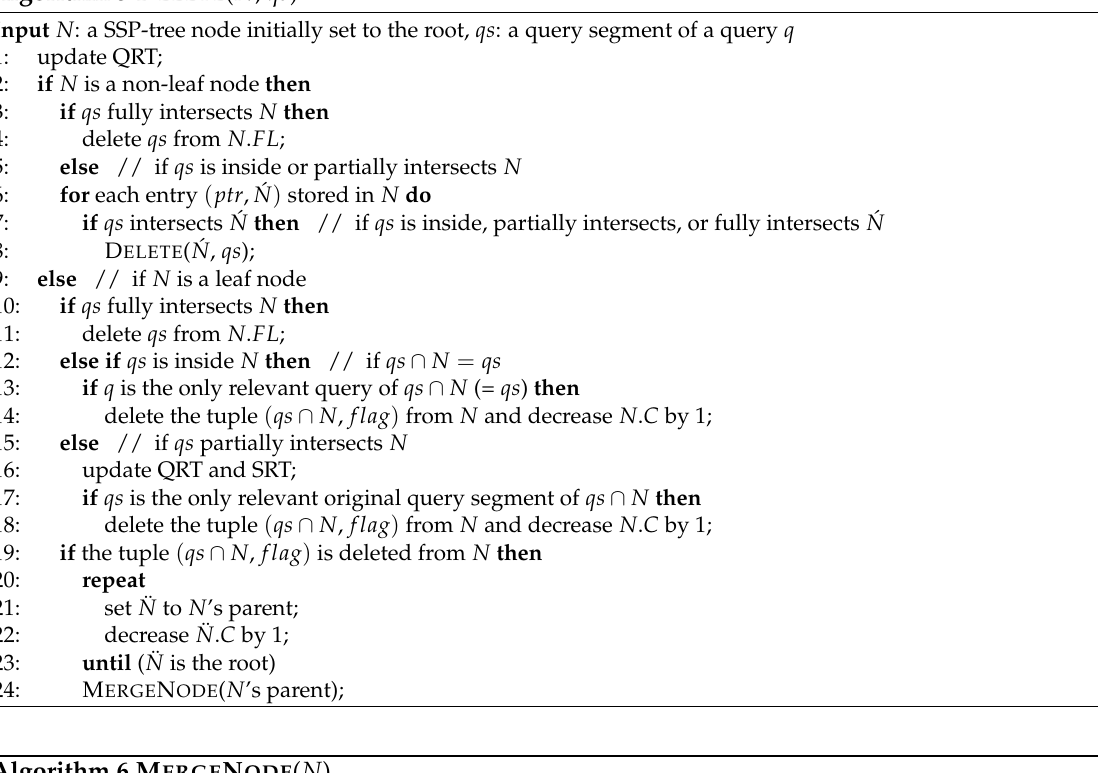
Algorithm 6 M ERGE N ODE ( N )